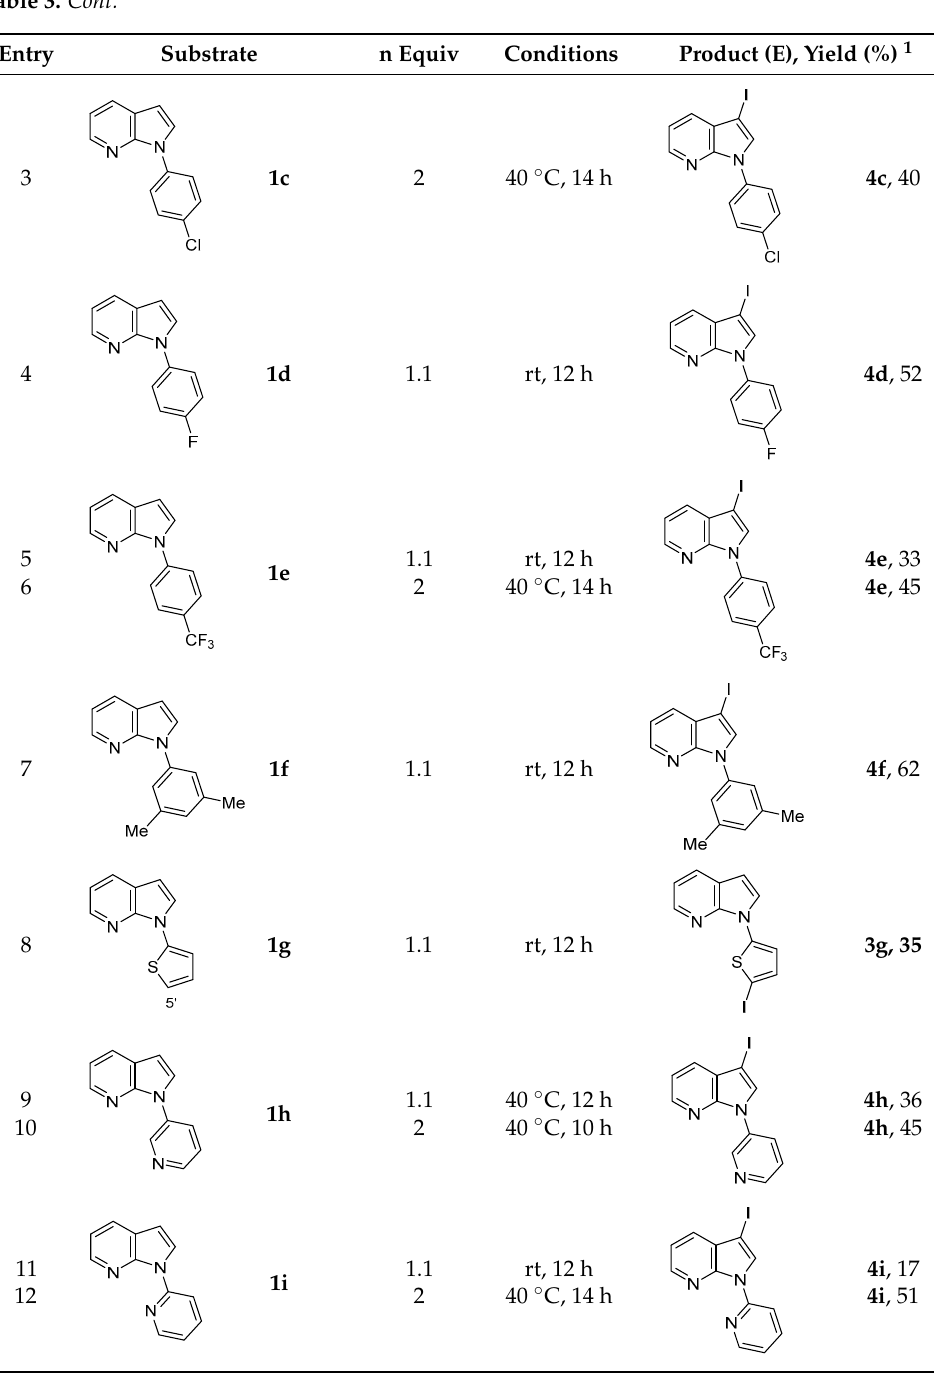
Figure 9. Calculated C charges (in brackets) and HOMO coefficients obtained by using the HuLiS calculator [73] for 7-azaindole, 1-phenylindole and 1-phenyl-7-azaindole ( 1a ). Next, we determined the charges and HOMO coefficients for the 1-arylated 7-azain- doles to attempt a prediction of the experimental results. For the 7-azaindoles bearing a substituted phenyl group 1b – 1f , all the maximum HOMO coefficients and the most neg- ative C charges were found at C3 (Figure 10). Experimentally, the 3-iodinated derivatives 4b , 4c , 4d and 4f were indeed the only products formed, as expected; they were isolated in yields ranging from 40% to 62% (Table 3, entries 2, 3, 4 and 7). It is interesting to note that the yield of the 3-iodinated product can be slightly improved by carrying out the reaction at 40 °C with an excess of iodine, as for example noticed in 1e (Table 3, entries 5 and 6). Figure 10. Calculated C charges (in brackets) and HOMO coefficients (obtained by using the HuLiS calculator [73]) for 1- (4-methoxyphenyl)-7-azaindole ( 1b ), 1-(4-fluorophenyl)-7-azaindole ( 1d ), 1-(3,5-dimethylphenyl)-7-azaindole ( 1f ), 1-(2- thienyl)-7-azaindole ( 1g ) and 1-(3-pyridyl)-7-azaindole ( 1h ).